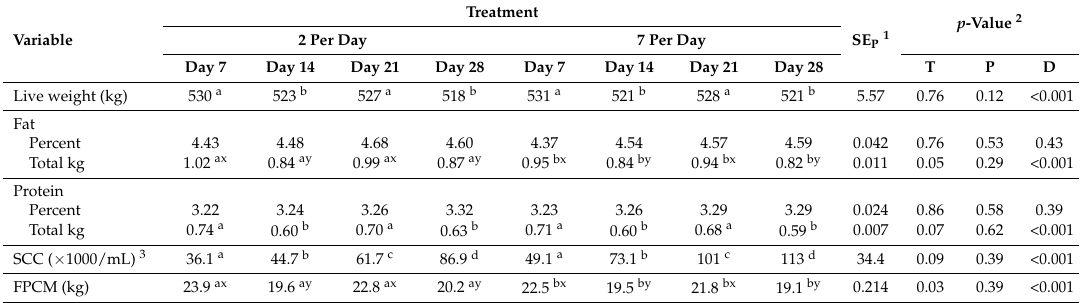
Table 2. Effect of frequency of provision of fresh pasture (Treatment: 2 allocations = 2 per day; 7 allocations = 7 per day) on cow live weight, milk composition, and the fat and protein corrected milk (FPCM) per sample day. Least square means and pooled standard errors are presented.